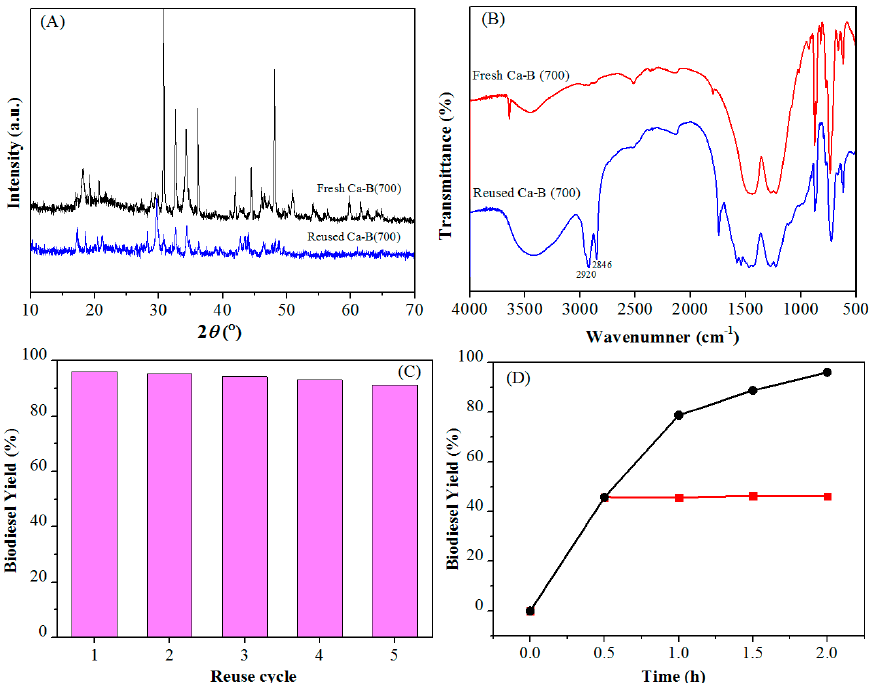
Figure 6. ( A ) XRD, ( B ) FT-IR spectra of Ca-B(700) before and after the reaction, ( C ) Reusability of the Ca-B(700) catalyst in biodiesel production. Reaction conditions: ethanol/oil molar ratio 20/1, 4 wt% Ca-B(700), 105 °C for 2 h, ( D ) Hot filtration test of Ca-B(700) at 105 °C.